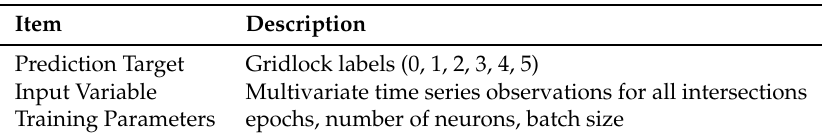
Table 3. Description of the LSTM model setup.